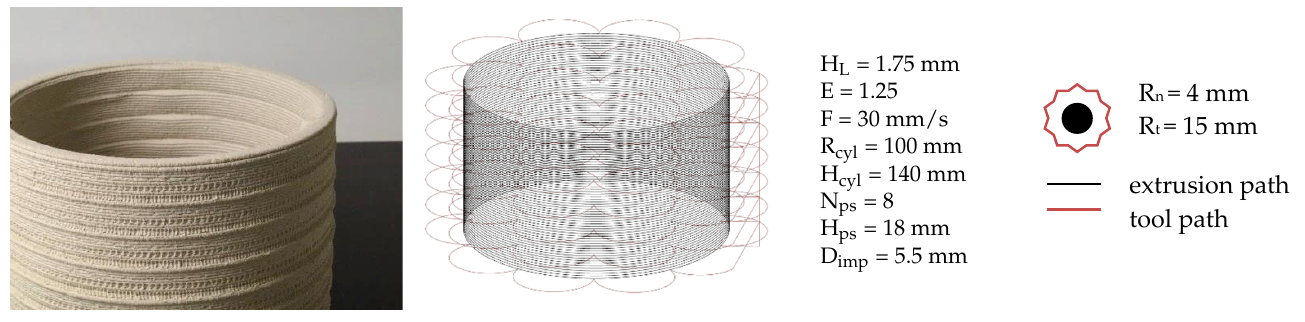
Table 4. Comparison of Grasshopper modelling as complex path instruction (material extrusion + tool) and materialized implementation with stamp tool and round material stencil in the LDM of clay.